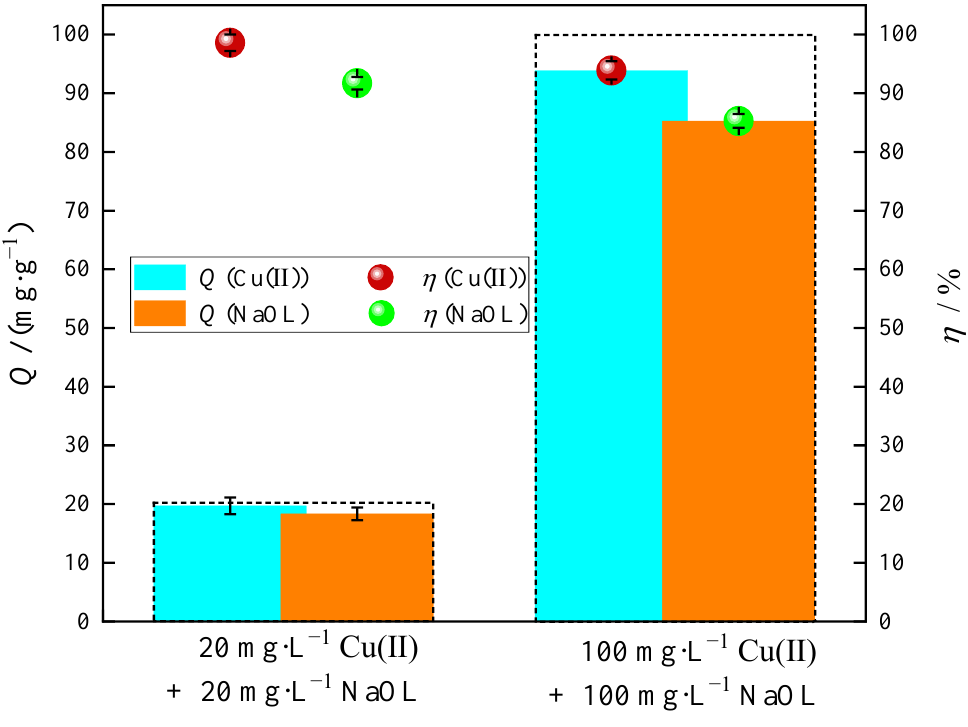
Figure 10. Multicomponent adsorption of Cu(II) and NaOL on SiO 2 – g – PBMA – b – PDMAEMA.